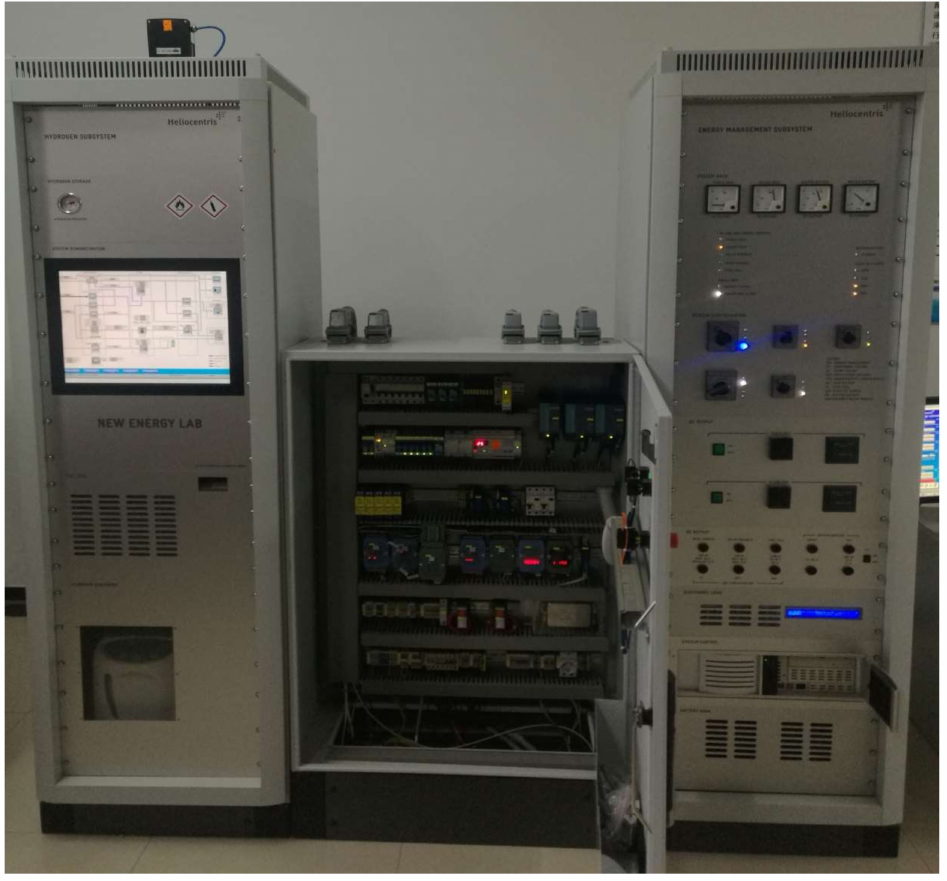
Figure 2. Integrated system